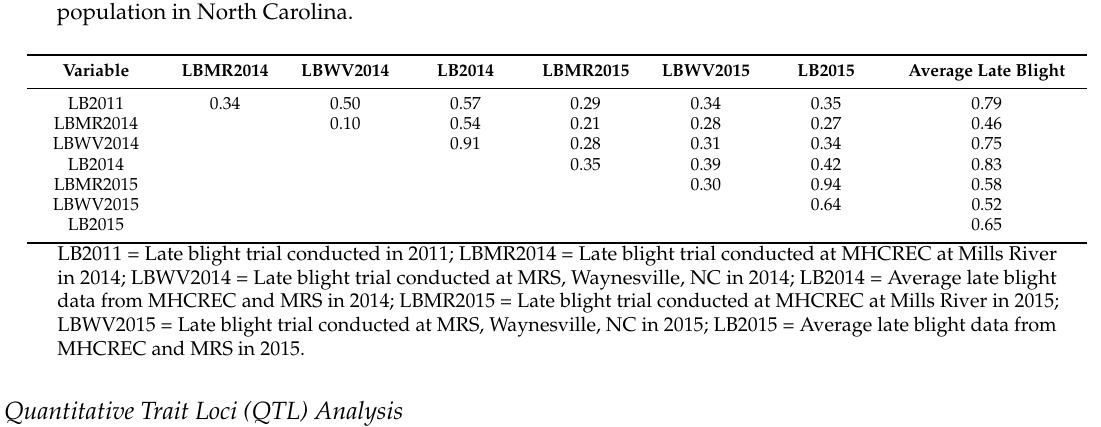
Table 2. Correlation analysis between various experiments for the evaluation of late blight in NC10175 population in North